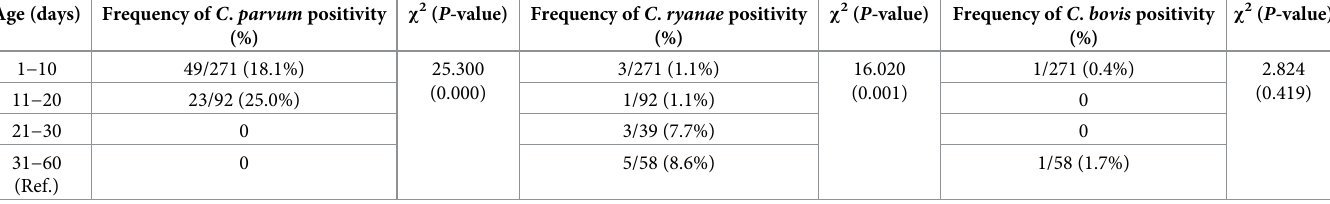
Table 2. Distribution of Cryptosporidium species in pre-weaned Korean native calves according to age group. Age (days) Frequency of C . parvum positivity χ 2 ( P- value) Frequency of C . ryanae positivity χ 2 ( P- value) Frequency of C . bovis positivity χ 2 ( P- value) (%) (%) (%) 1 − 10 49/271 (18.1%) 25.300 2.824 (0.000) (0.419) 11 − 20 23/92 (25.0%) 1/92 (1.1%) 0 21 − 30 0 3/39 (7.7%) 0 31 − 60 (Ref.)